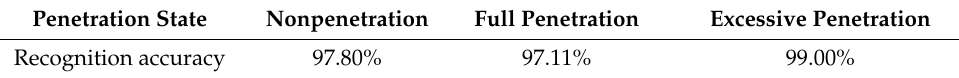
Table 6. Recognition accuracy of the penetration state by using BP neural network.